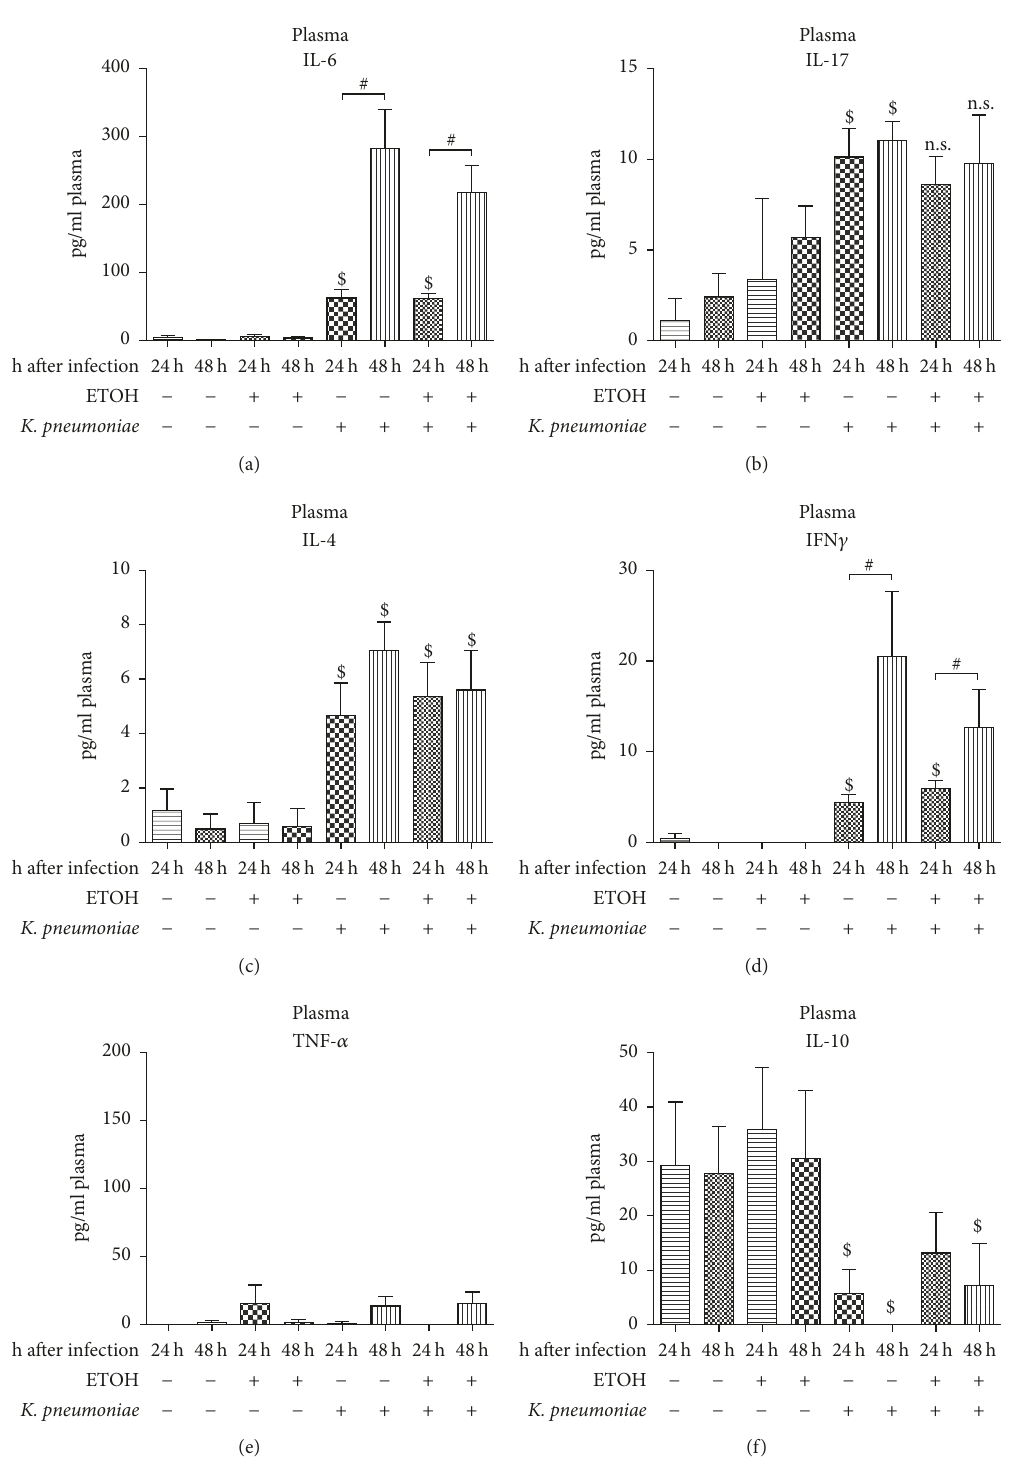
Figure8:Proteinlevelsof(a)IL-6,(b)IL-17,(c)IL-4,(d)IFN- 𝛾 ,(e)TNF- 𝛼 ,and(f)IL-10inplasmainamurinemodelofethanolexpositionfor 2 weeks, surgery, and pulmonary infection. Protein levels of indicated cytokines were analyzed by cytometric bead array (CBA) and given as pg/ml plasma of ethanol-treated (ETOH) and saline-treated controls (NaCl) at 24 hours or 48 hours after pulmonary infection with Klebsiella pneumoniae . $ 𝑝 < 0.05 when compared to time- and treatment-matched control (infection-dependent effects); # 𝑝 < 0.05 when comparing 24 hours to 48 hours (time-dependent effects); data are presented as mean ± SEM, Mann–Whitney U test ( 𝑛 = 8 each group). n.s.: not significant. IL: interleukin; TNF- 𝛼 : tumor necrosis factor; IFN- 𝛾 : interferon gamma; ETOH: ethanol treatment; K . pneumoniae : pulmonary infection with Klebsiella pneumoniae